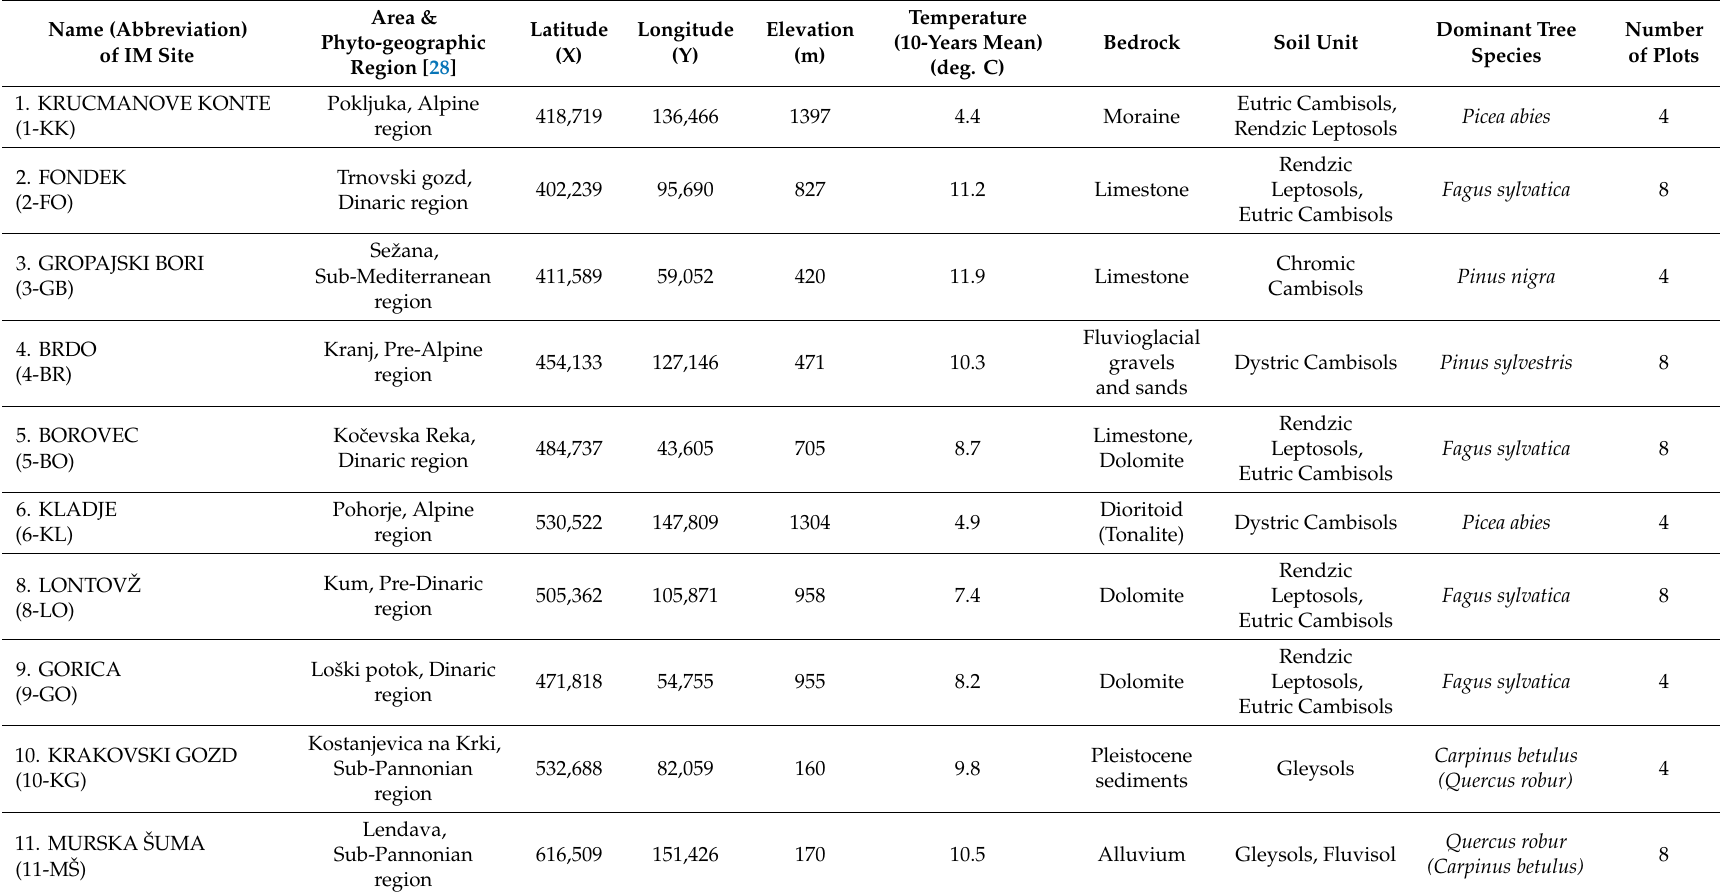
Table 1. Main characteristics of Intensive Monitoring (IM) sites in Slovenia